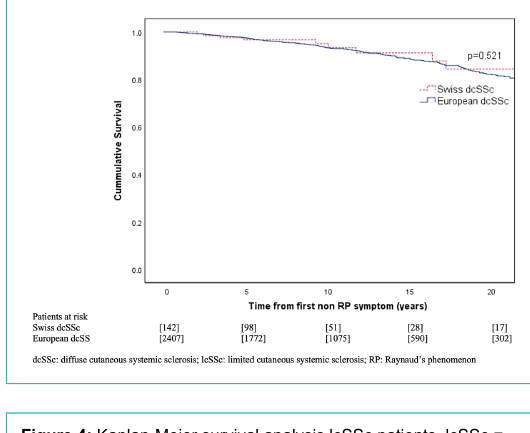
Figure 3: Kaplan-Meier survival analysis dcSSc patients. dcSSc = diffuse cutaneous systemic sclerosis; RP = Raynaud’s phenome- non.